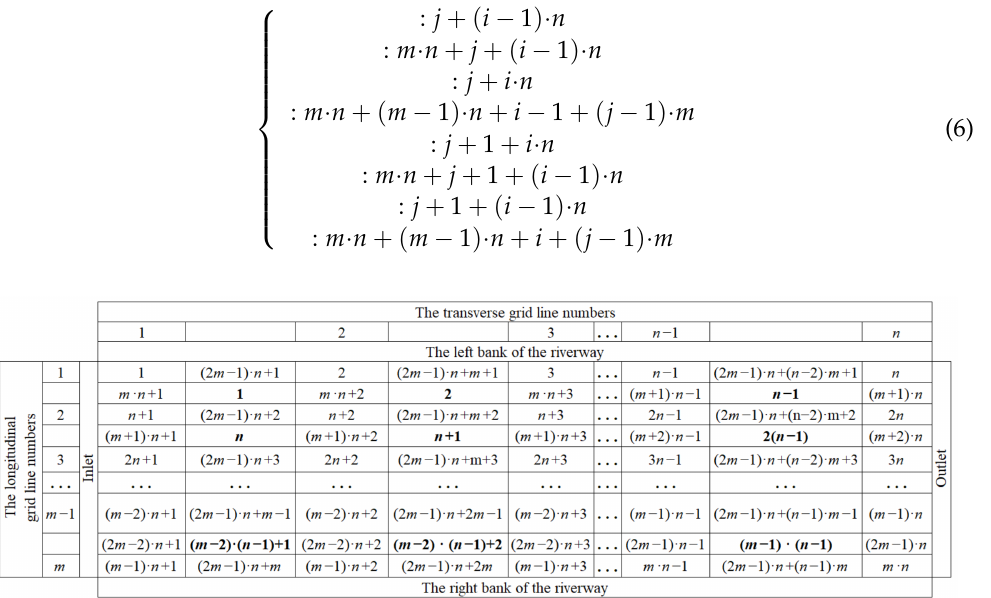
Figure 12. Coding rules of nodes and cells of the SMS quadrilateral grid file (The rows marked “1, 2, . . . , m ” represent longitudinal grid lines; the columns marked “1, 2, . . . , n ” represent longitu- dinal grid lines; the bold values in the figure are the cell numbers; and the values around the bold values are the node numbers).